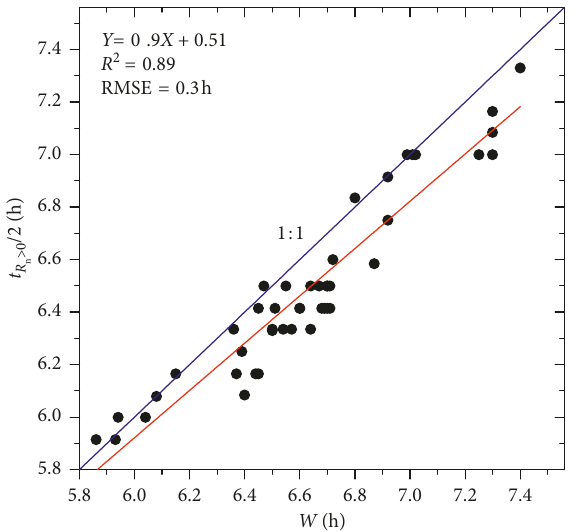
Figure 3: The relationship between w and t